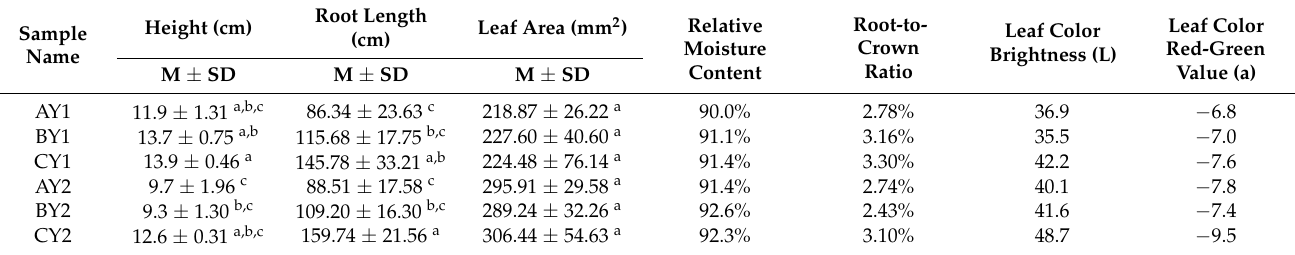
Table 1. Agronomic traits of quinoa under different temperature